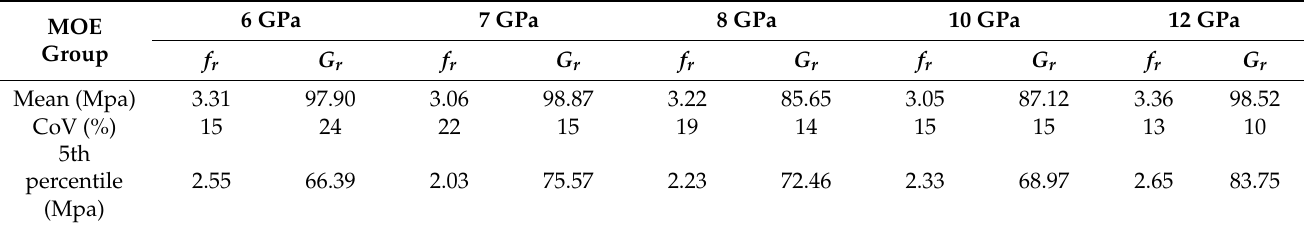
Table 4. Rolling shear properties of southern pine with varying